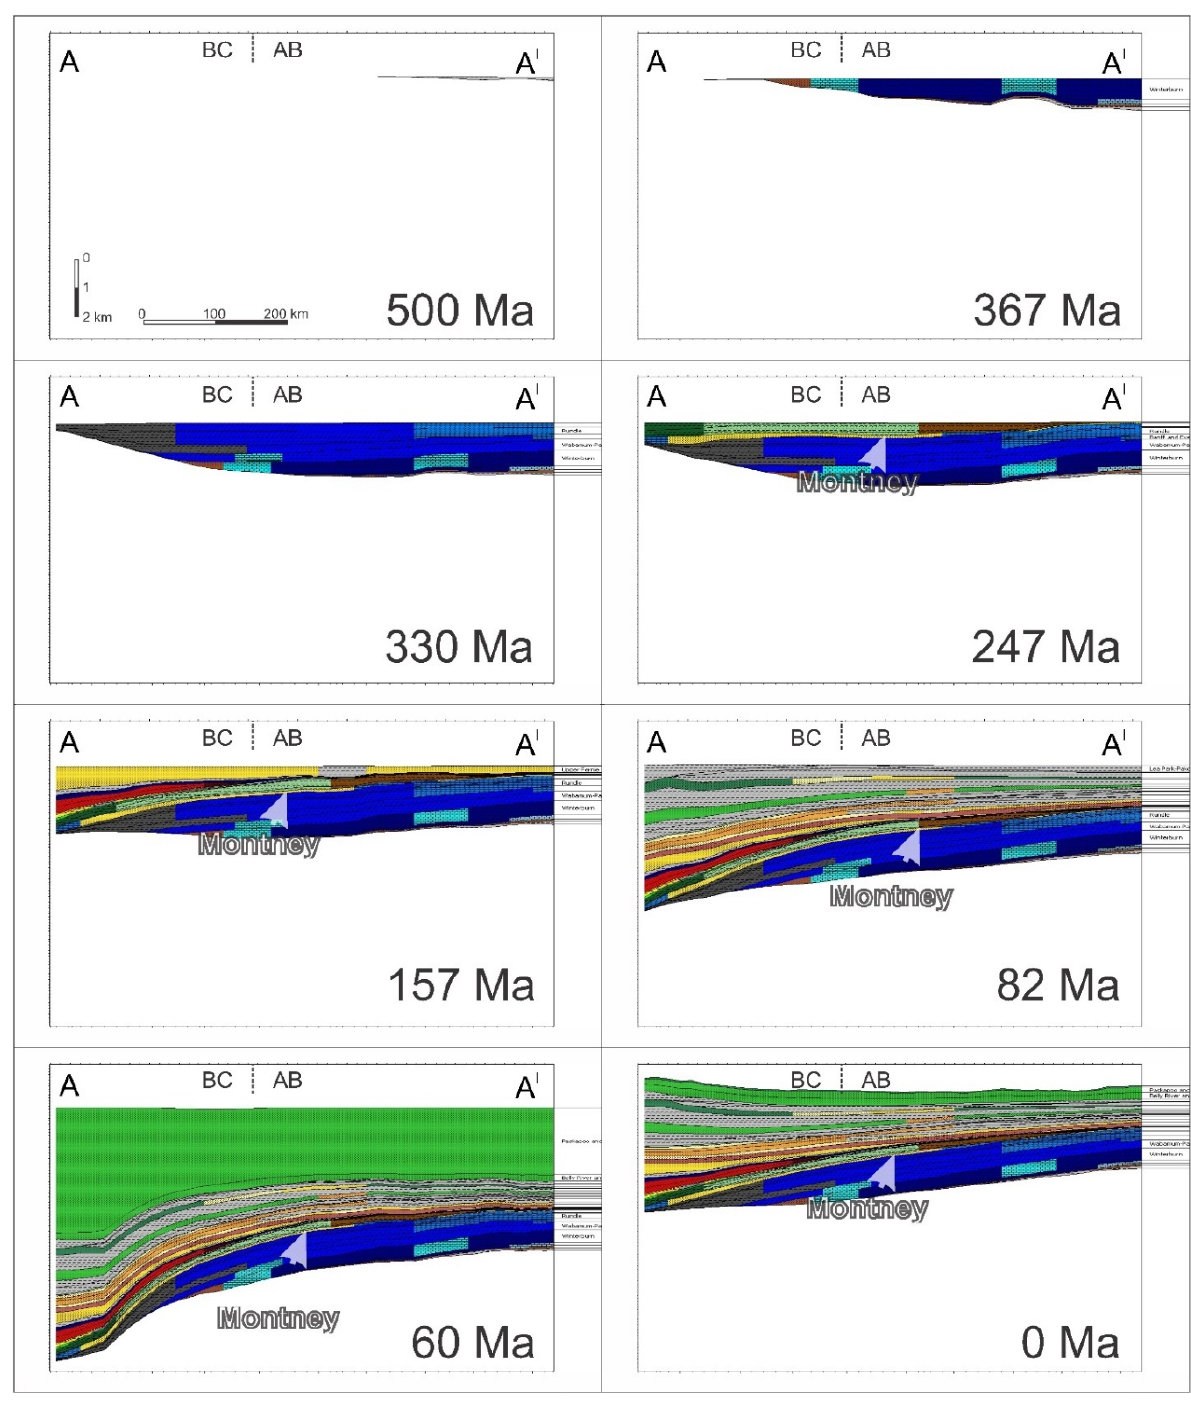
Figure 15. Cross-section A–A ′ along the stratigraphic dip of the basin, showing the burial at different times, highlighting the Montney Formation. Facies legend shown below in Figure 16, and location is shown in Figure 2. Note the cross-section at time 0 Ma is still the A–A ′ location.